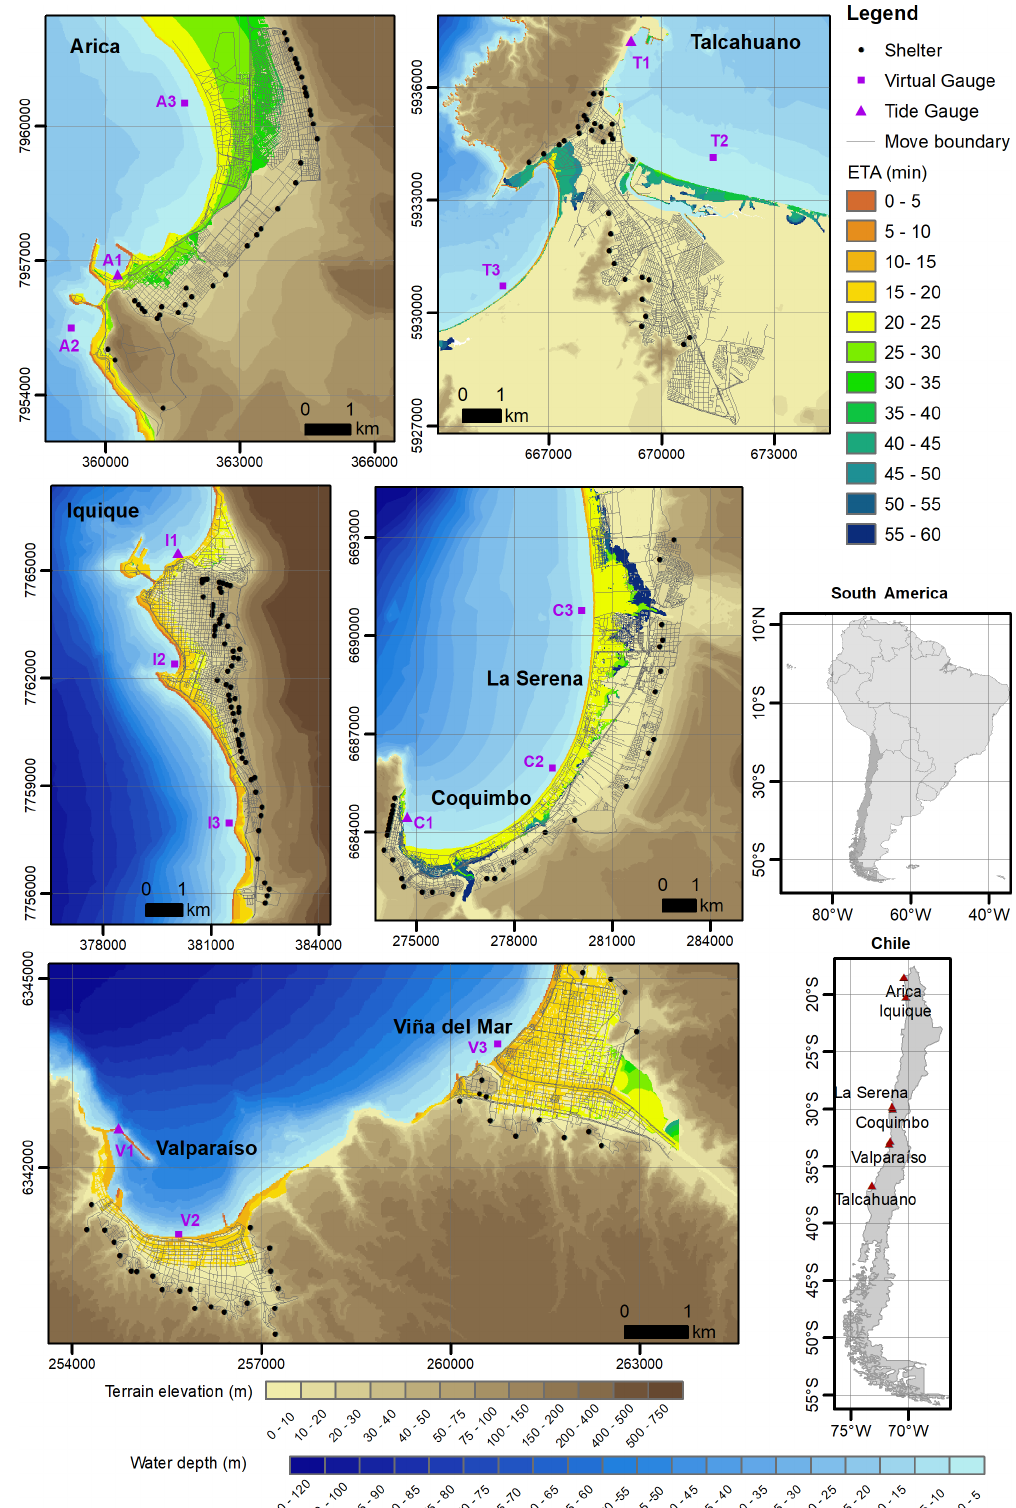
Figure 1. Location, topo-bathymetry, and tsunami-related features of the examined case studies in Chile.